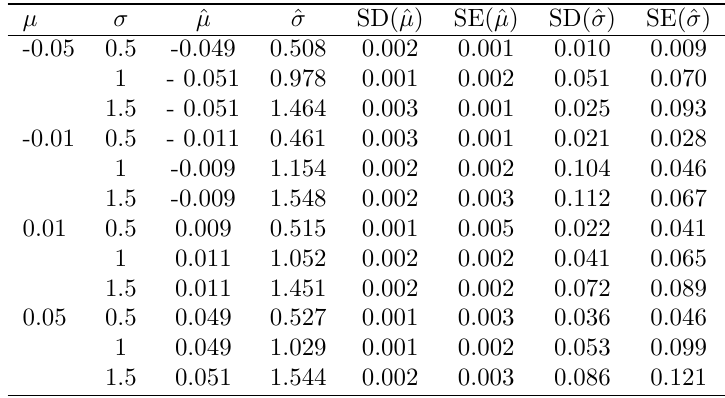
Simulation study - Maximum likelihood estimates of ( (cid:22); (cid:27) ) for various choices of parameters. Standard deviations over 1000 replications of dataset of size n = 1000 . SE stands for the asymptotical standard errors of the maximum likelihood estimates.